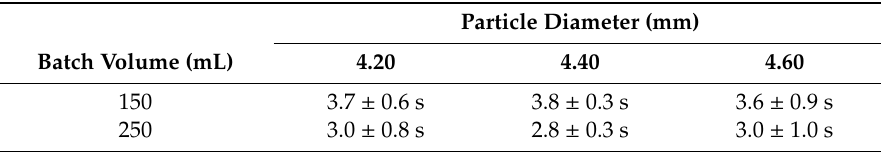
Table 6. Particle residence times for 150 mL and 250 mL batch volumes and particle diameters